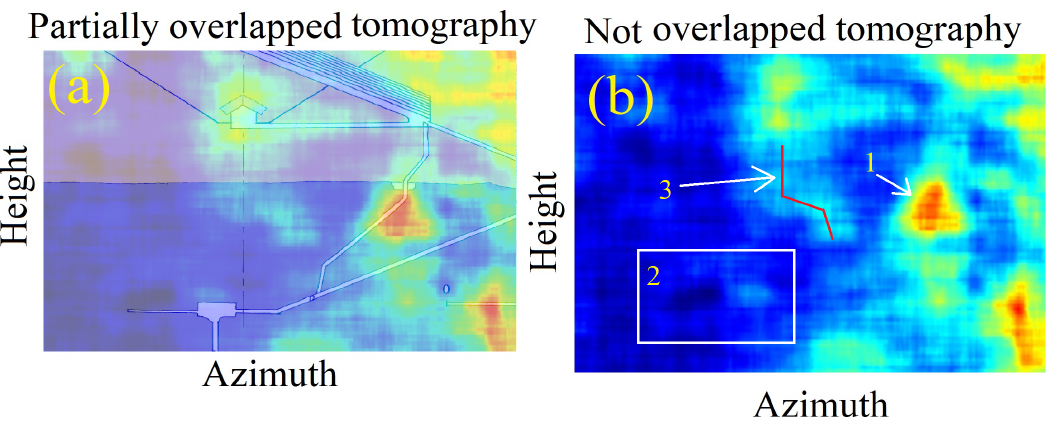
Figure 27. ( a ): Schematic representation of Figure 24b box 3 details partially overlapped with tomographic result. ( b ): tomographic result of Figure 24b box 3 details.